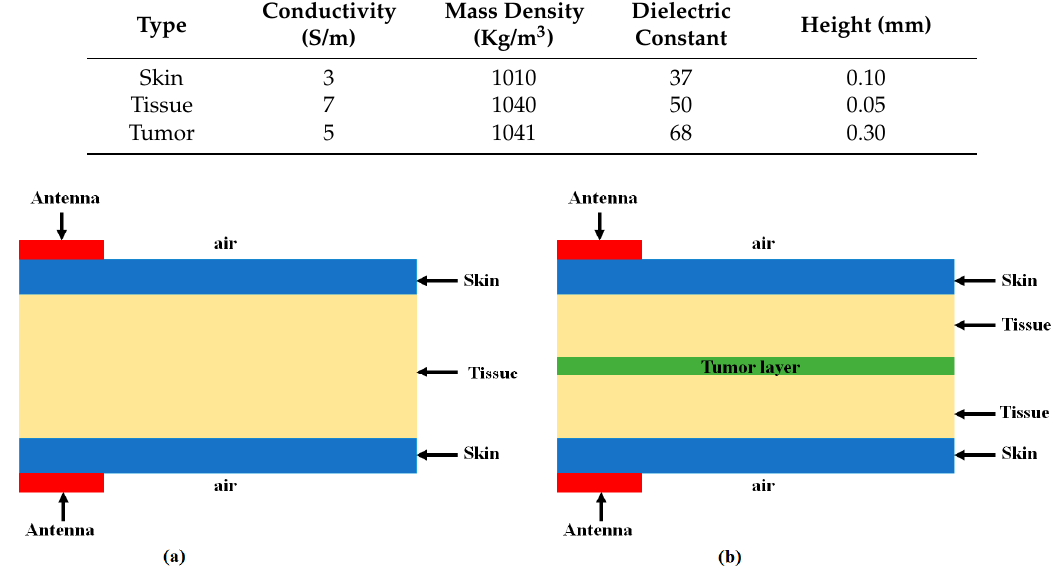
Figure 9. Model developed for investigating received signal responses with biological organic stacked layers (cross view); ( a ) Model developed without tumor layer; ( b ) Model developed with tumor layer [17].